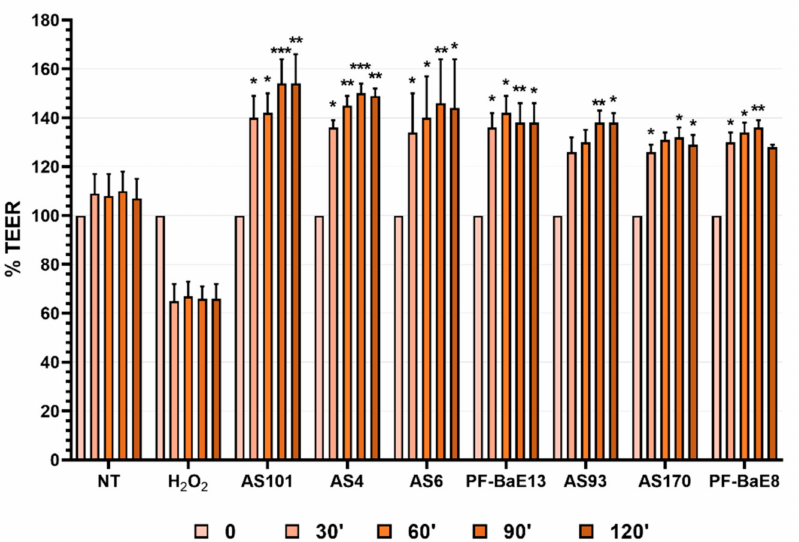
Figure 3. Strains preventing H 2 O 2 -induced paracellular permeability in vitro. Caco-2 cell monolayers were put in contact with the selected bacteria (MOI 10:1) and then sensitized with H 2 O 2 at T0 (100 µ M). NT corresponds to the untreated cells control and H 2 O 2 to the cells only treated with oxygen peroxide. The %TEER was calculated as follows: TEER at Time X/TEER at T0 × 100. For each condition, data were expressed as the means of 3 independent experiments ± SEM. Statistical analysis refers to the comparison of cells treated with bacteria and H 2 O 2 versus the H 2 O 2 control. * p < 0.05; ** p < 0.01, *** p < 0.001.